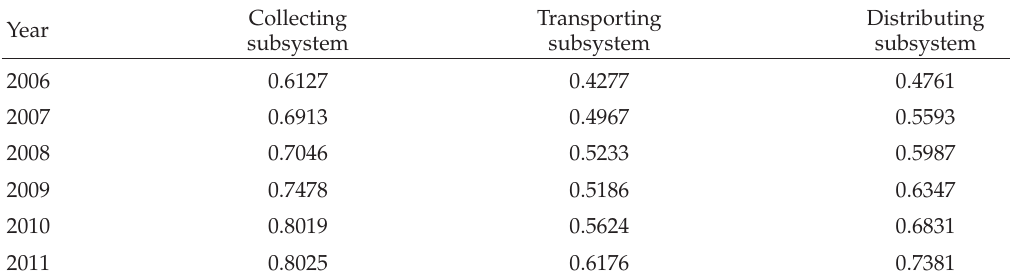
Table 3: The degree of order of each